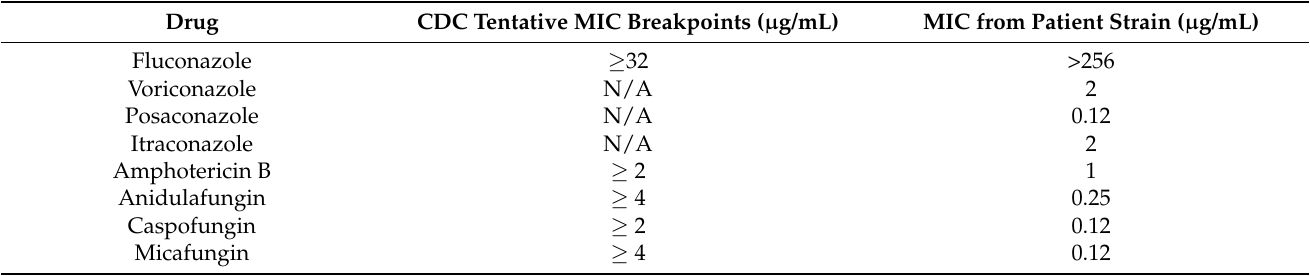
Table 1. Comparison between CDC-suggested tentative MIC breakpoints and antifungal susceptibility test from patient (and mother) isolated